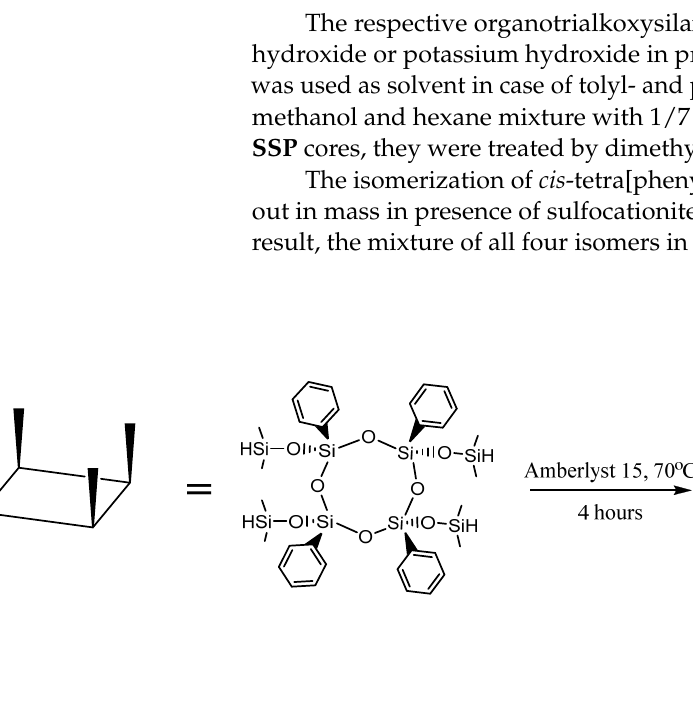
Scheme 2. Scheme of cis -tetra[phenyl(dimethylsiloxy)]cyclotetrasiloxane